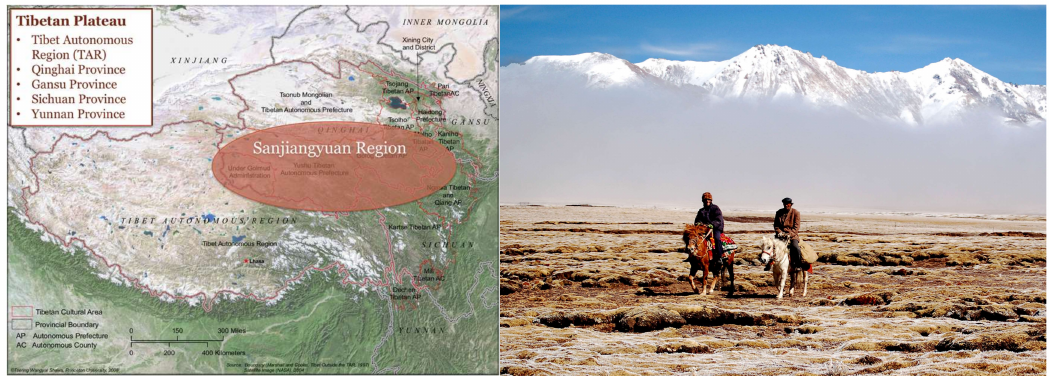
Figure 3. Map of the Tibetan Plateau and Sanjiangyuan (adapted from [66]), and Tibetan pastoralists riding their horses in the high altitude rangeland circa 4600 m asl near the source of the Mekong